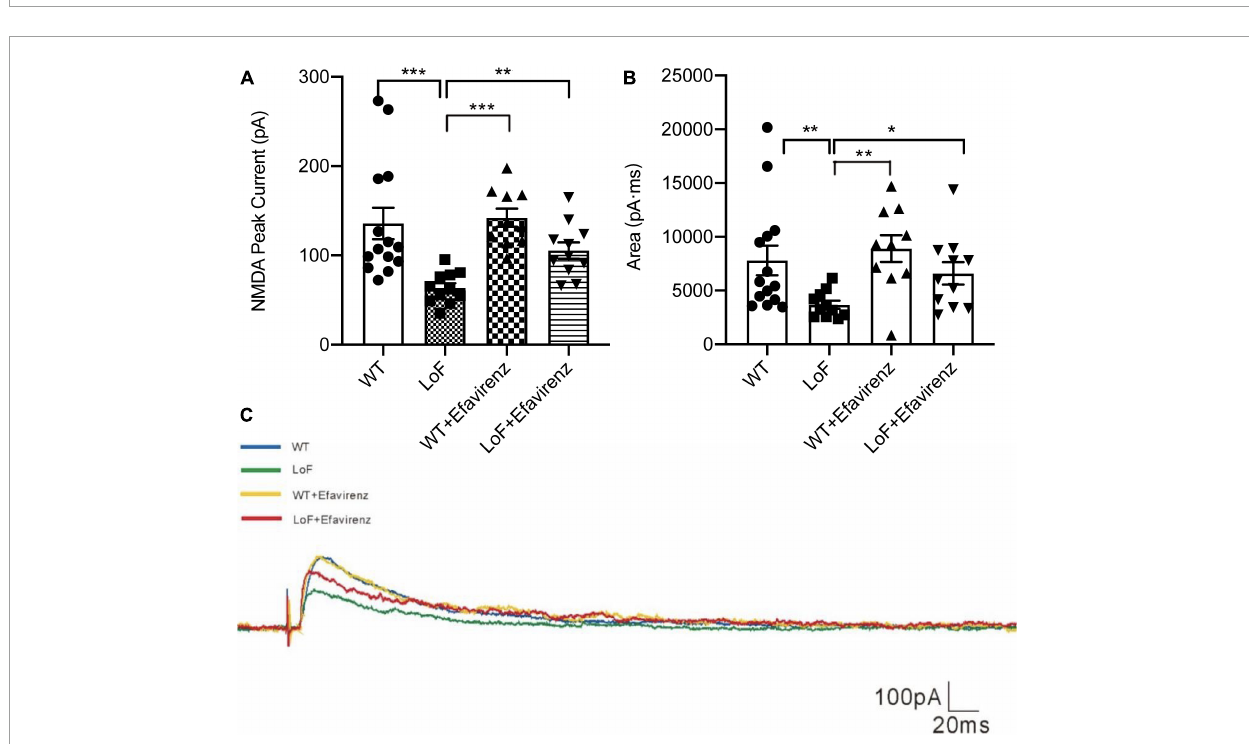
FIGURE4 The peak current and current area of NMDAR in pyramidal cells in hippocampal CA1 region of mice. The mouse brain slices were used for patch-clamping recording in pyramidal cells in the hippocampal CA1 region of mice. The peak current (A) and current area (B) of NMDA current were recorded. The typical current are shown (C) . * P < 0.05; ** P < 0.01; *** P < 0.001.